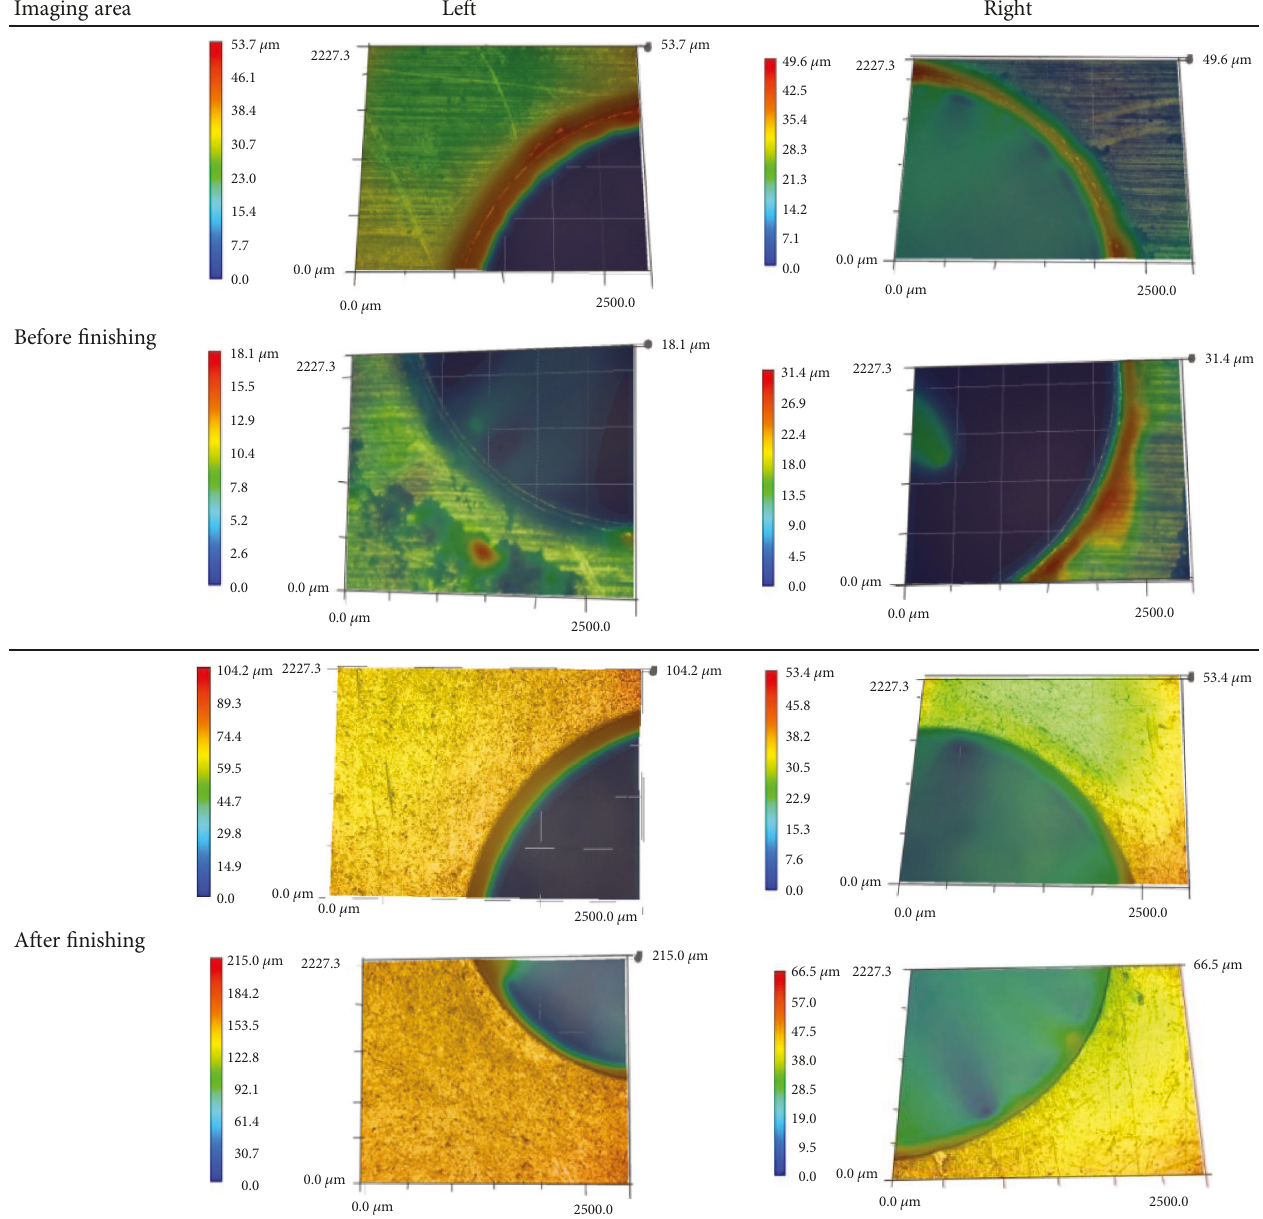
Table 10: The contrast photos before and after fi nishing using Plan 2. Imaging area Left